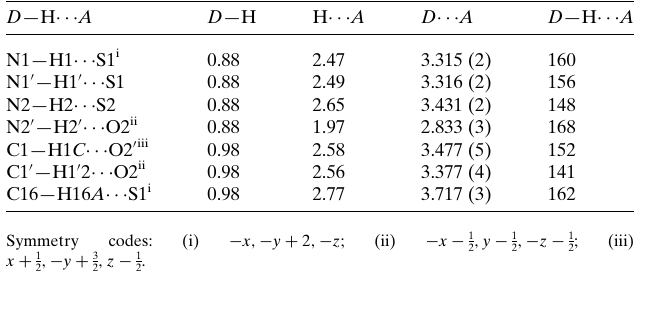
Table 2 Experimental